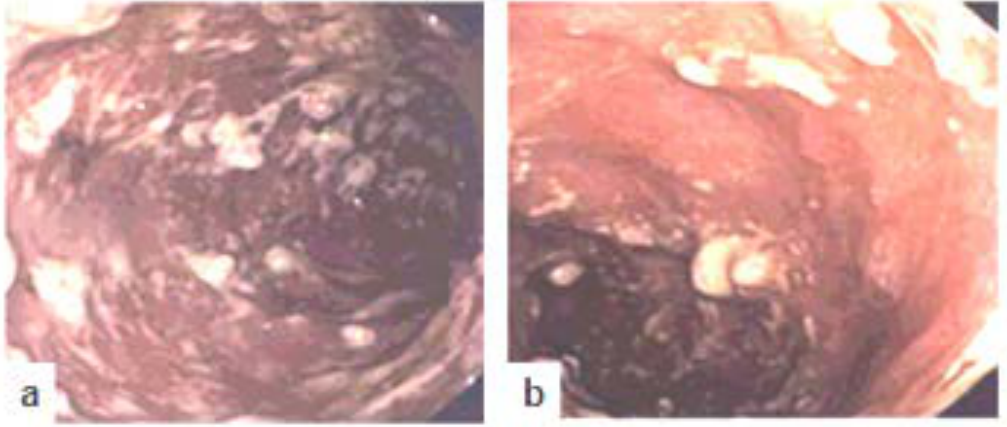
Figure 2. Colonoscopy (2018) with image representatives. ( a ) Transverse colon: Ulcerative colitis; ( b ) Descending colon: Inflammation, pseudopolyps. Inflammatory response with pseudopolyps and ulceration has been extended to the upper portion of the colonic tissues.